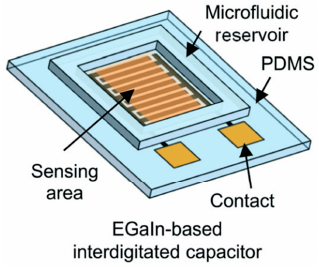
Figure 7. All-soft microfluidic chemical sensing platform using gallium-based liquid metal (EGaIn) and PDMS for liquid-phase and gas phase VOC detection. Reproduced with permission from [49] Copyright 2017, Royal Society of Chemistry.